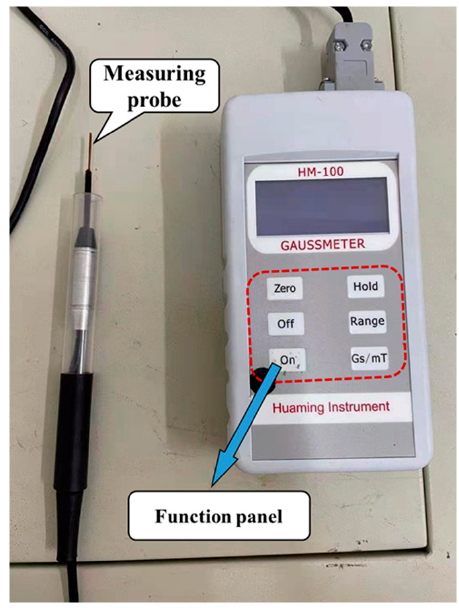
Figure 3. HM-100 Tesla meter for measurement.